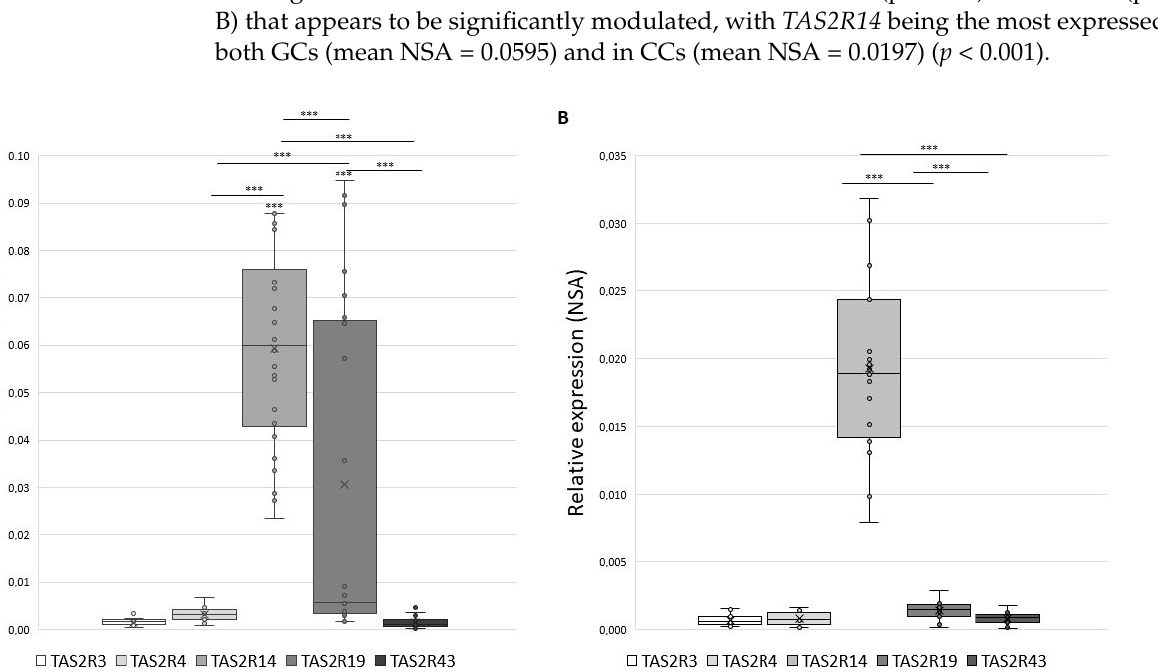
Figure 1. Gene expression of TAS2Rs in GCs (panel A) and in CCs (panel B) expressed as Normalize Sample Amount. Graphical diagrams are plotted as box–whisker plots, where boxes show the interquartile range with median and mean values, and whiskers represent min and max confidence intervals. Statistically significant differences in NSA levels were tested by Kruskal–Wallis one-way analysis of variance followed by the Dunn’s post-hoc test. *** p < 0.001.